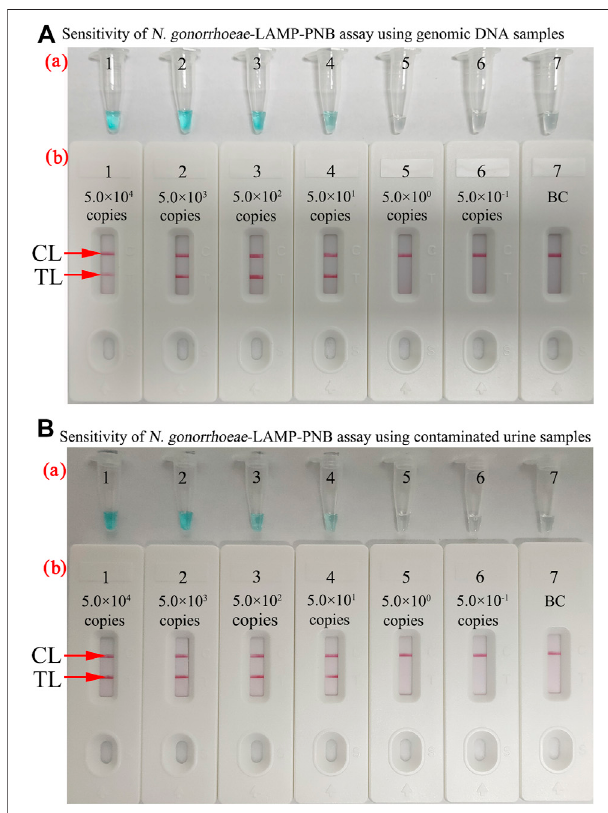
FIGURE 5 | Sensitivity of the N. gonorrhoeae -LAMP-PNB assay. (A) Sensitivity of the N. gonorrhoeae -LAMP-PNB assay using diluted genomic DNA templates. MG (a) and PNB (b) were applied for reporting the N. gonorrhoeae -LAMP results. Tubes a1 – a7 (Biosensors b1 – b7) represent the genomic DNA levels of 5.0 × 10 4 copies, 5.0 × 10 3 copies, 5.0 × 10 2 copies,5.0 × 10 1 copies,5.0 × 10 ° copies,and 5.0 × 10 − 1 copies per reaction and blank control (DW), respectively. (B) Sensitivity of the N. gonorrhoeae - LAMP-PNB assay using contaminated urine samples. Each healthy volunteer ’ s urine samples contained different concentrations of N. gonorrhoeae strains (ranging from 5.0 × 10 4 to 5.0 × 10 − 1 copies/ μ l). The N. gonorrhoeae -LAMP wasperformedasdescribedabove, and theresults were analyzed with MG (a) and PNB (b), respectively. Tubes a1 – a7 (Biosensors b1 – b7) represent the N. gonorrhoeae strain concentrations of 5.0 × 10 4 copies,5.0 × 10 3 copies,5.0 × 10 2 copies,5.0 × 10 1 copies,5.0 × 10 ° copies, and 5.0 × 10 − 1 copies per reaction and blank control (DW), respectively. The results suggested that the LoD of the N. gonorrhoeae -LAMP-PNB assay was 5.0 × 10 1 copies per test. CL: control line; TL: test